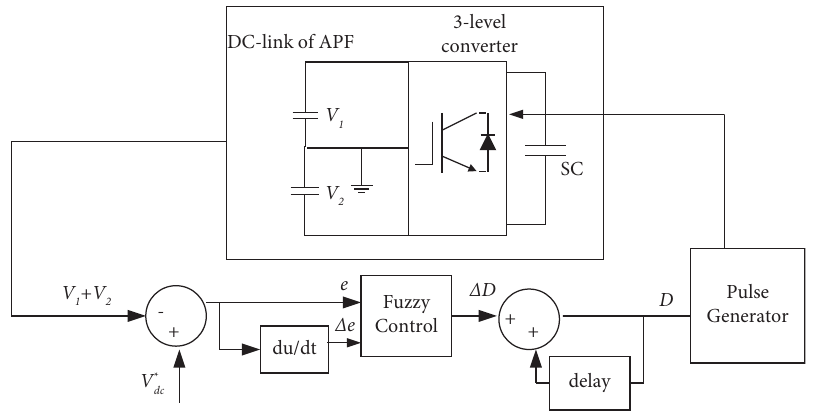
Figure 7: Closed loop control of the SC circuit.